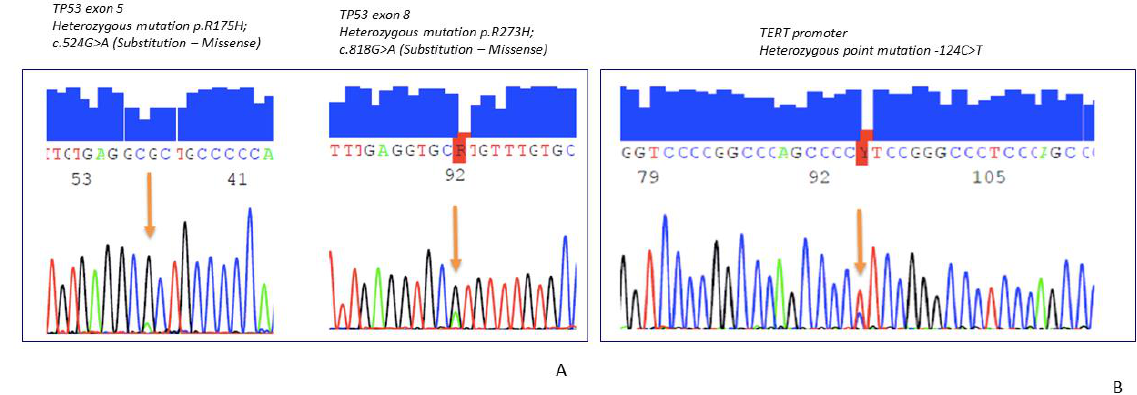
Figure 3. ( A ) High-risk SFT with TP53 mutation, ( B ) Intermediate-risk SFT with HTER mutations.